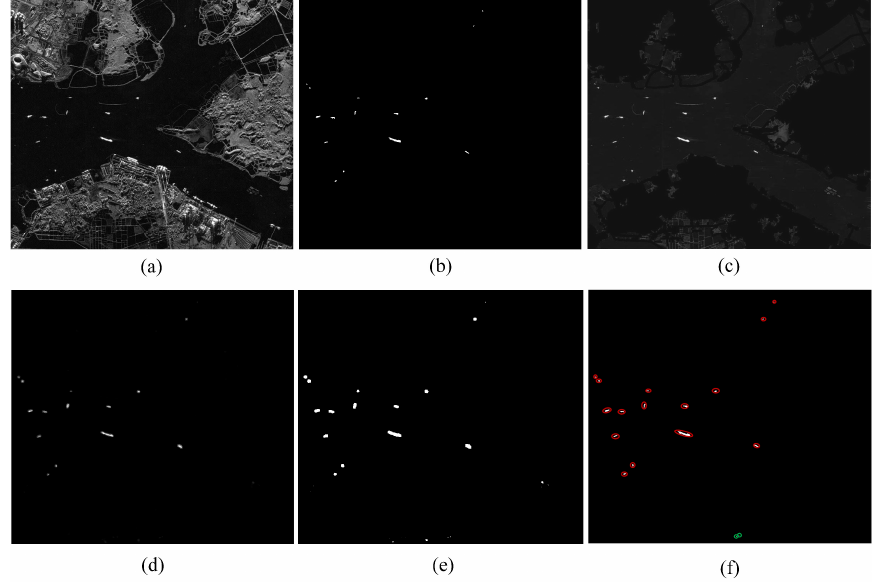
Figure 8. The detection results. p fa = 10 − 6 ( a ) Input image. ( b ) Ground truth. ( c ) Otsu result. ( d ) Saliency map. ( e ) Coarse detection result. ( f ) Fine detection result. The red ellipses and green ellipses in the figures represent the correct and false test results respectively.